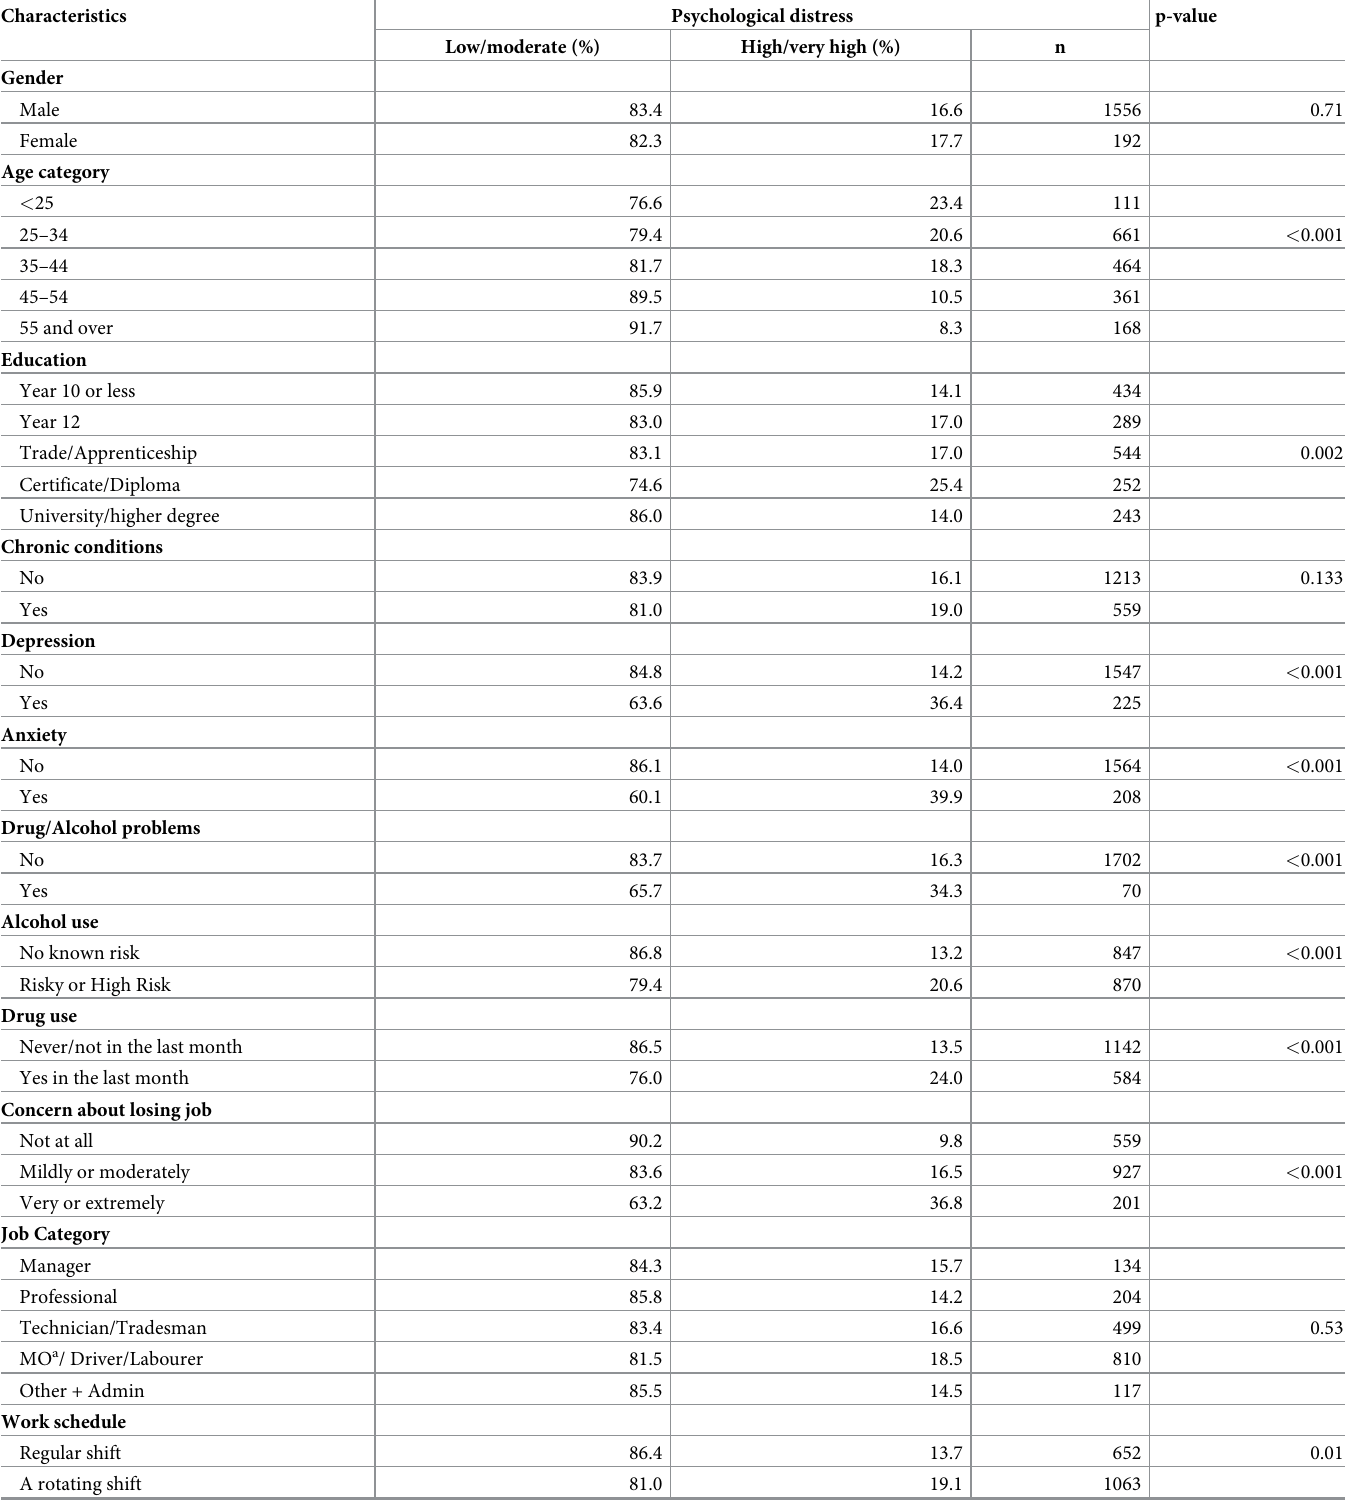
Table 3. Prevalence of psychological distress by characteristics of the sample (n = 1772).